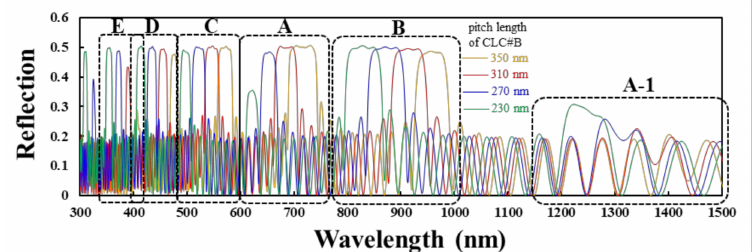
Figure A1. Simulation results of the reflection spectra of BLCPFs, with wavelength ranging from 300 nm to 1500 nm, realized by fixing the pitch length of CLC#A at 560 nm and by decreasing the pitch length of CLC#B from 350, to 310, 270, and 230